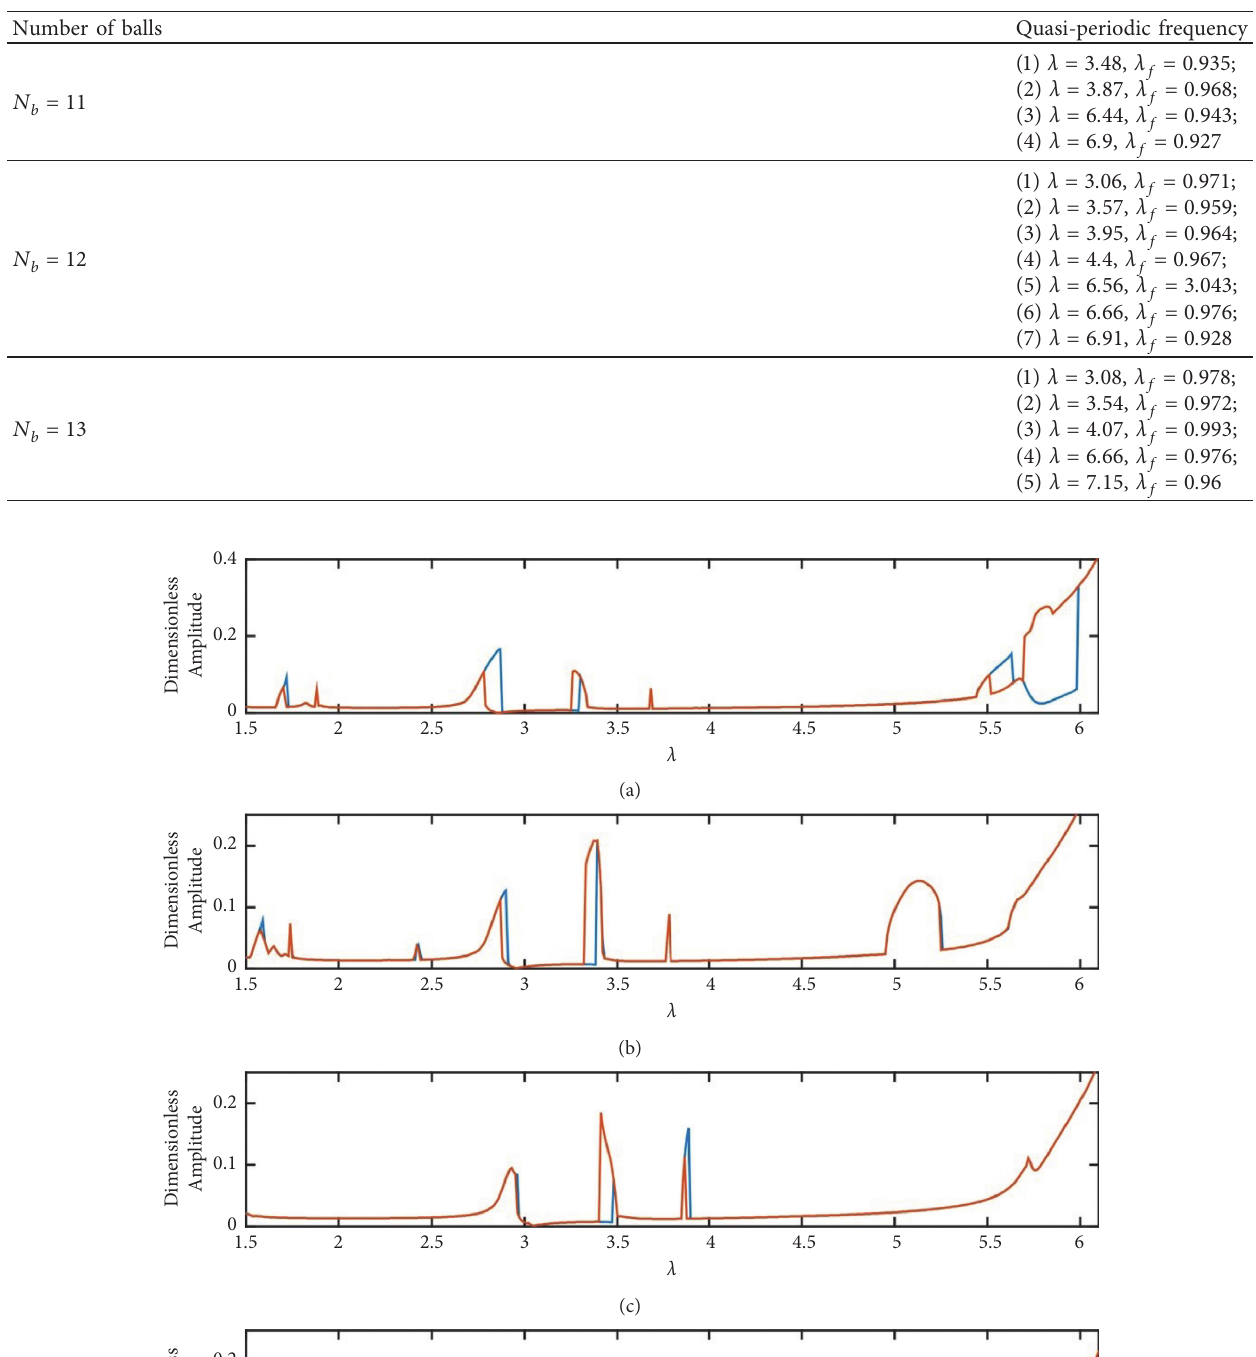
Table 2: The quasi-periodic frequency with different numbers of